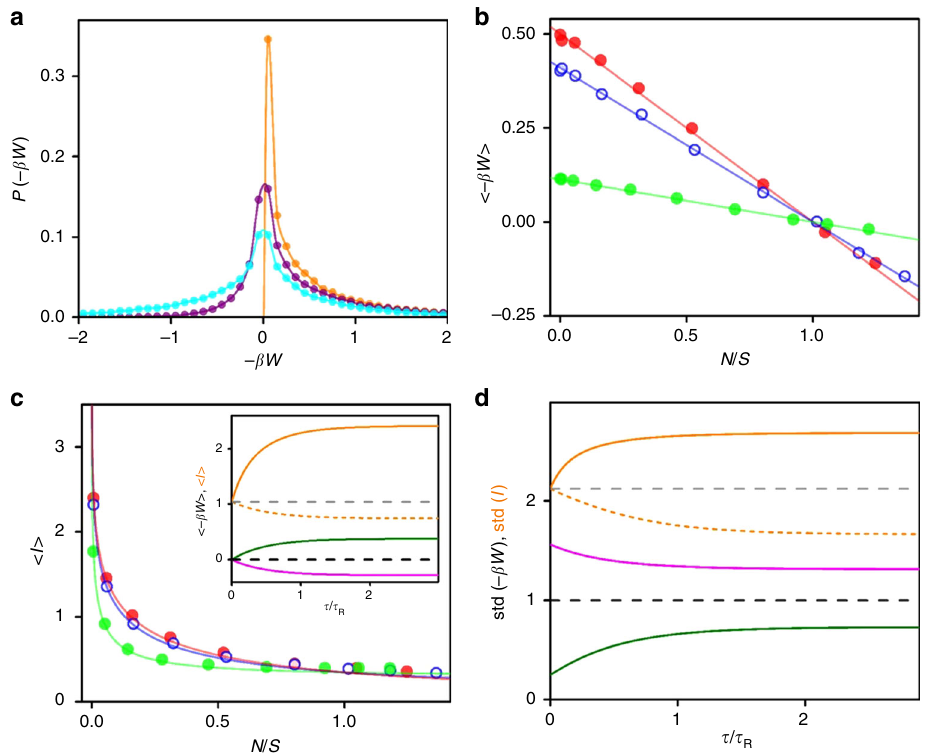
Fig. 3 Measurement of work and mutual information. a Experimentally measured probability distribution functions of the extracted work − β W at steady state for cycle τ = 20 ms and noise levels N / S = 0 (orange), 0.31 (purple) and 1.12 (cyan). The solid curves are guides to the eyes. b The average extracted work 〈 − β W 〉 as a function of noise level N / S , for τ = 20 (red circles), 3 (blue), and 0.5 (green) ms. The solid lines are plot of Eq. (2). c The measured average mutual information in steady state 〈 I 〉 , as a function of N / S for τ = 20 (red circles), 3 (blue), and 0.5 (green) ms. The solid curves are plot of Eq. (4). Inset: theoretical plot of 〈 − β W 〉 and 〈 I 〉 as a function of normalized cycle period τ / τ R (using Eqs. (2) and (4)) for N / S = 0.5 (olive and orange curves), 1.0 (black and grey dashed lines), and 1.25 (magenta and dashed orange curves) for 〈 − β W 〉 and 〈 I 〉 , respectively. For better visualization, all values of mutual information are scaled up by a factor of 3. d Fluctuations in work std( − β W ) and mutual information std( I ) as a function of τ / τ R for like colored curves in the inset of panel c